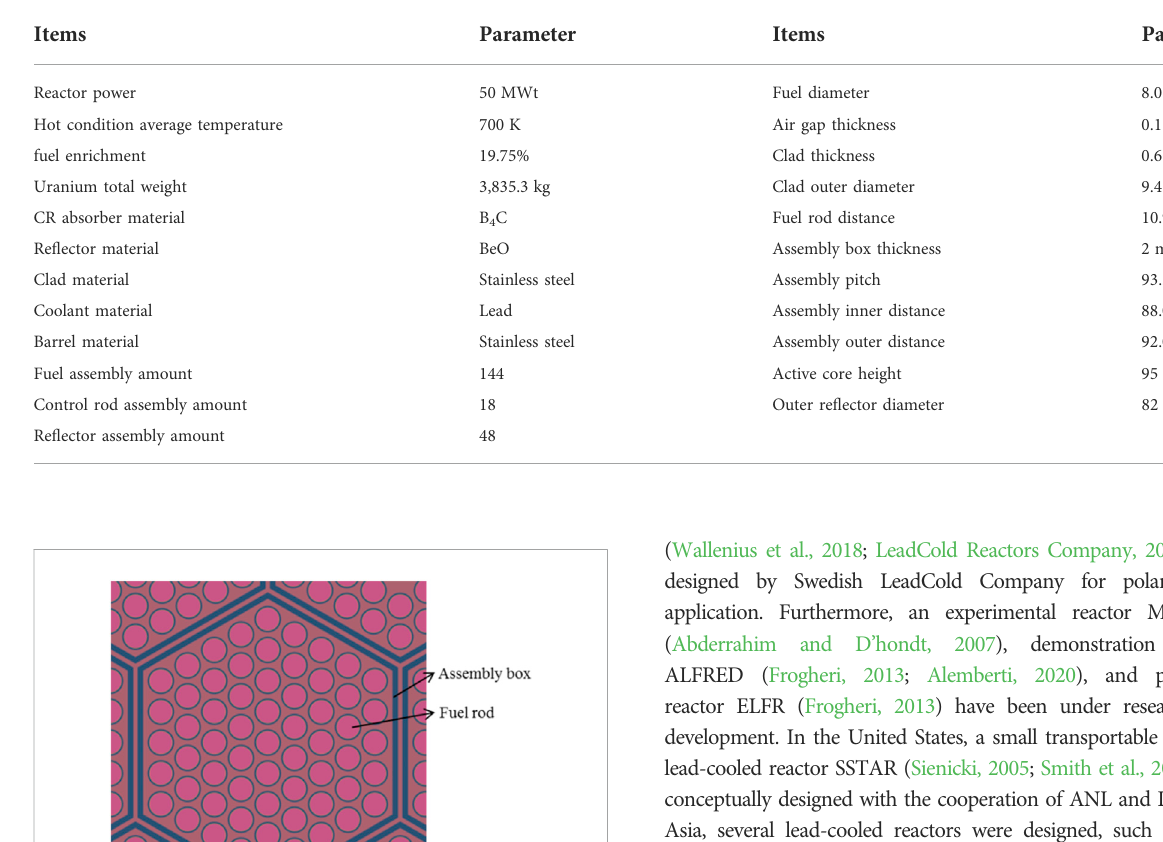
TABLE 1 Original parameters of the SLBR-50 reactor (Zhao et al., 2021).